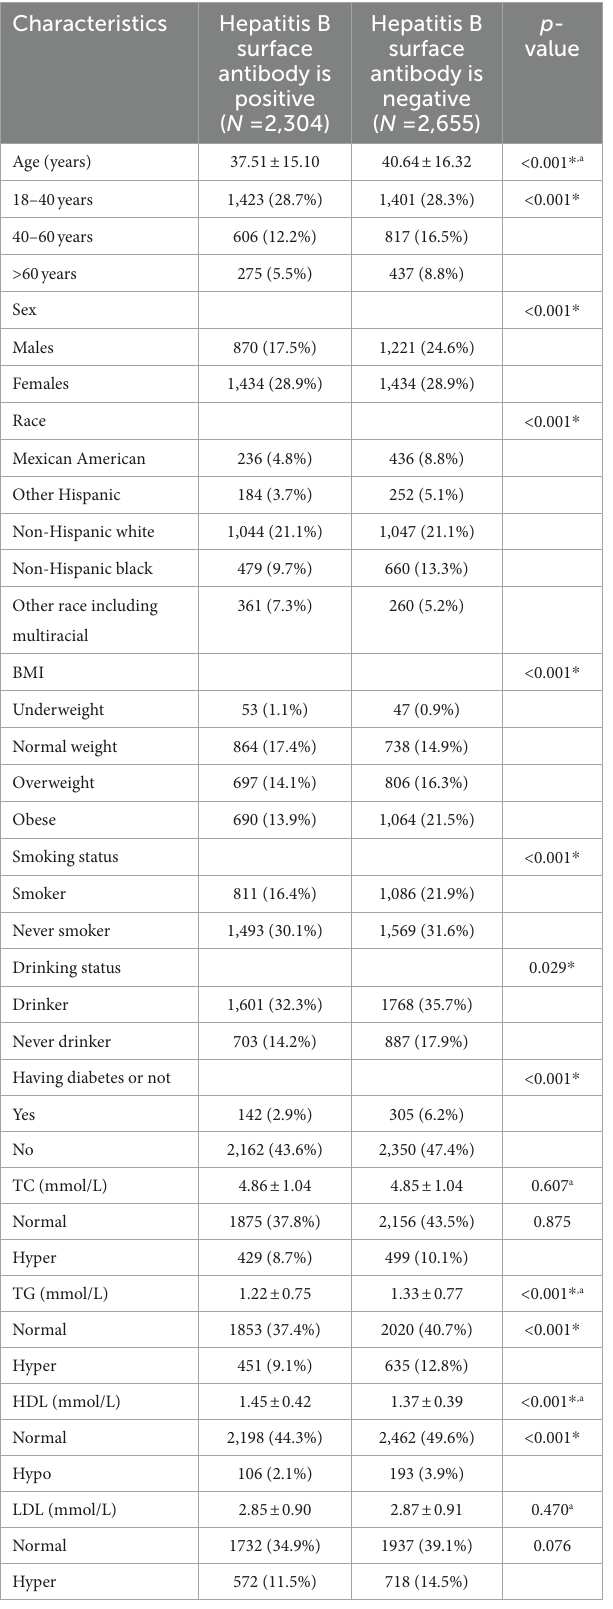
TABLE 1 Characteristics of 4,959 participants in NHANES data, 1999–